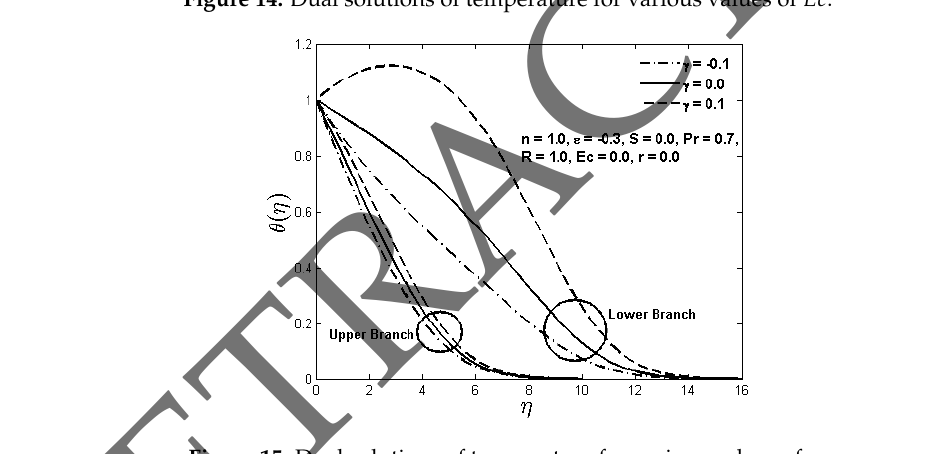
Figure 15. Dual solutions of temperature for various values of γ